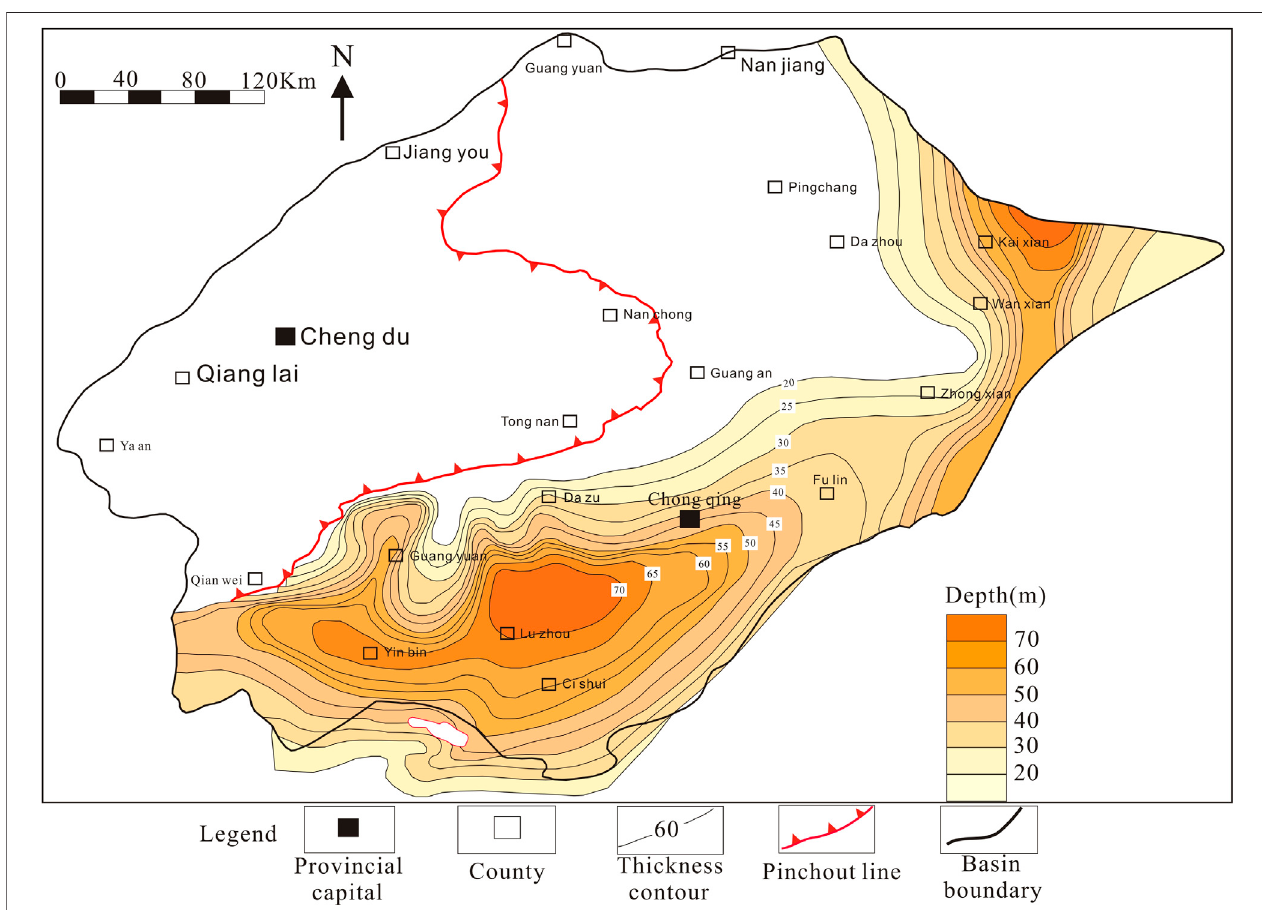
FIGURE 7 | Plane distribution of high-quality shale thickness in southern